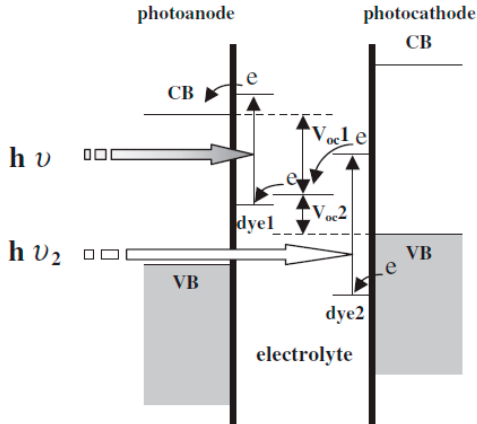
Figure 7. Principle of operation of a t ‐ DSC in which the dye ‐ sensitizers of the photoanode and the photocathode absorb light in different portion of the solar spectrum (feature of complementary absorption). Bent arrows indicate the displacement of the electrons from photocathode to photoanode within the cell as mediated by the dye ‐ sensitizers in the light ‐ induced excited state. Thick horizontal arrows indicate the different energies of the photons absorbed by the distinct sensitizers of the photocathode and photoanode. Reprinted with permission from reference [28].